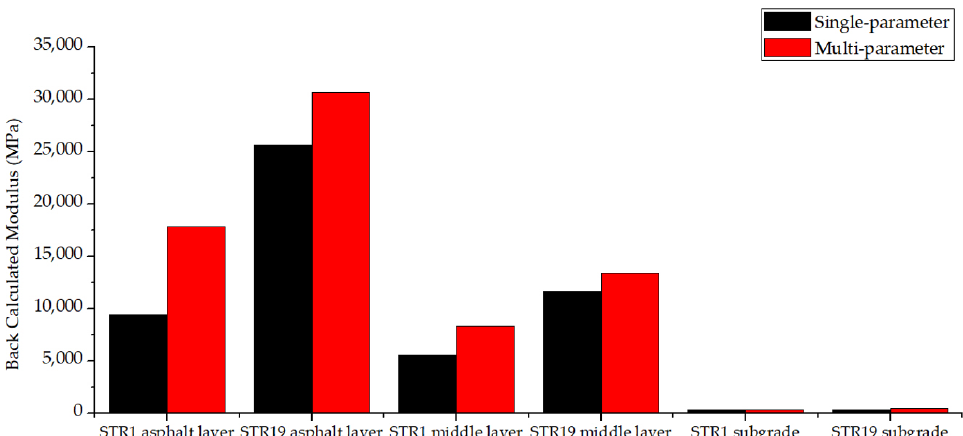
Figure 15. The back calculated modulus.